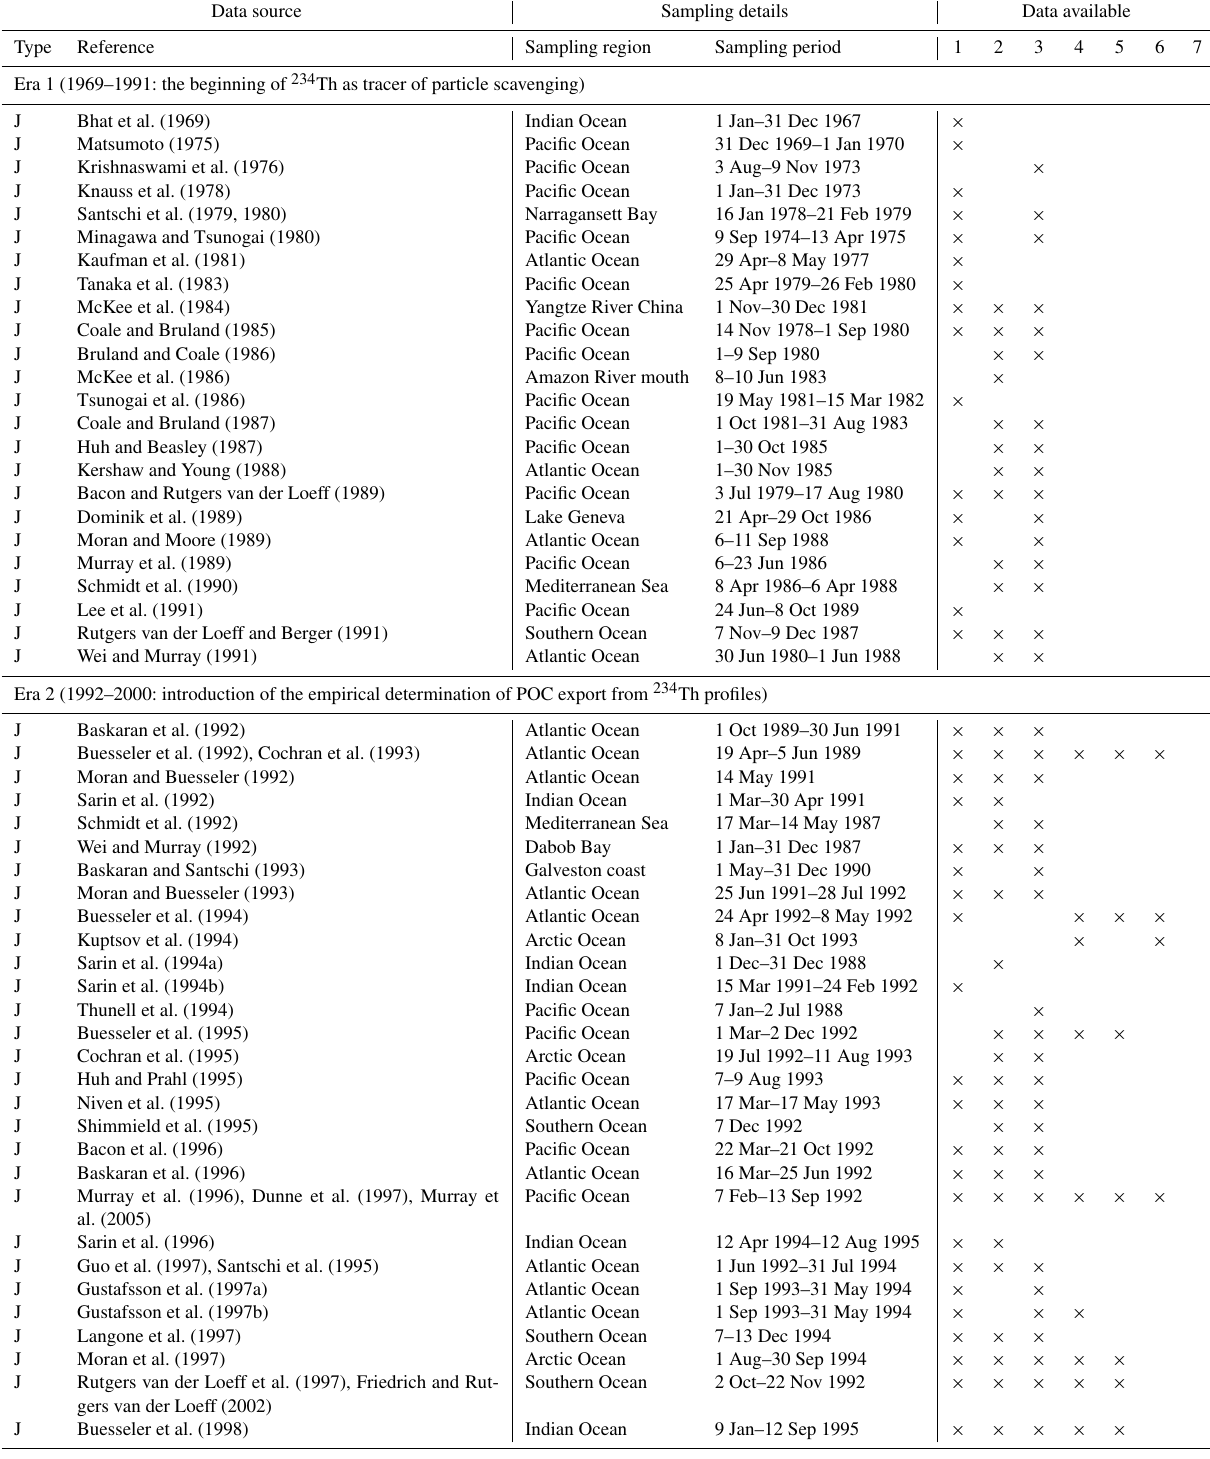
Table 1. Summary of the studies included in the compilation in chronological order of publication. Four types are distinguished as data source type: publications in refereed journals (J), publication in repository (R), PhD thesis (T), and personal communication (P) for unpublished data sets released in this compilation. Note that in some cases, published data have been reported in different publications, for which all the publications are indicated. Basic information of sampling details (i.e., region and period) is also included. Additionally, availability of seven different categories of 234 Th data are indicated with an “ × ” as follows: (1) total 234 Th, (2) dissolved 234 Th, (3) particulate 234 Th, (4) POC : 234 Th ratios from filtration methods, (5) PON : 234 Th ratios from filtration methods, (6) POC : 234 Th ratios from sediment traps,